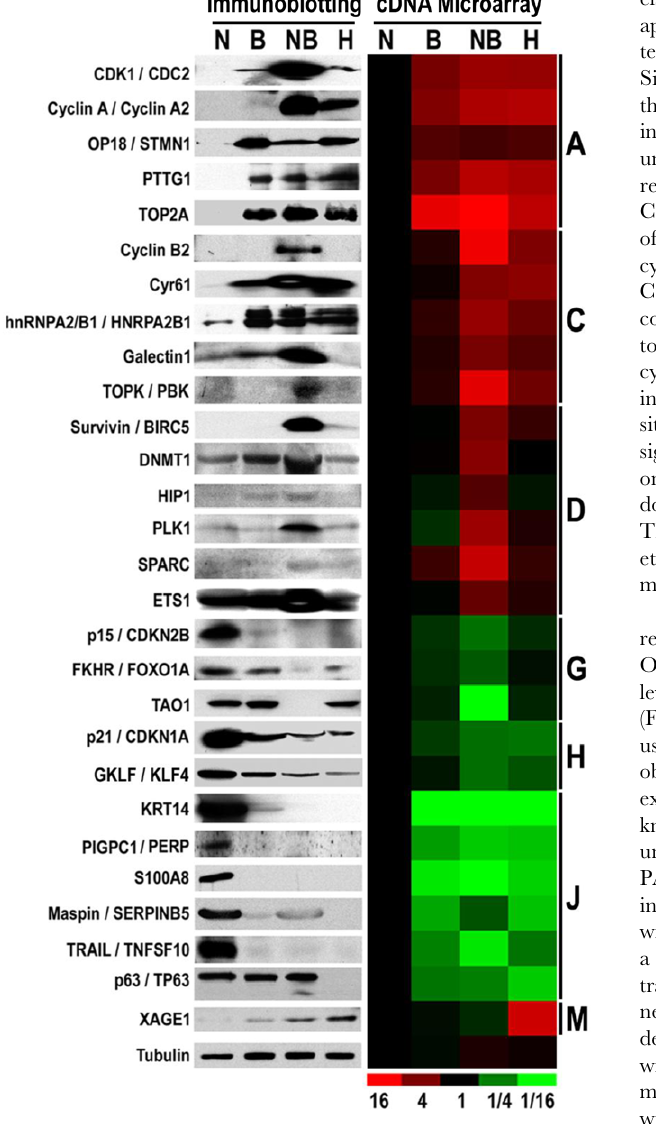
Figure 2. Immunoblotting and comparison of expression changes between protein and mRNA levels. Immunoblotting analysis in NHBE (N), BEAS-2B (B), NNK-BEAS-2B (NB) and H157 (H) cells for 28 Molecules from representative groups, and the comparison of expression changes with mRNA levels from microarray data.